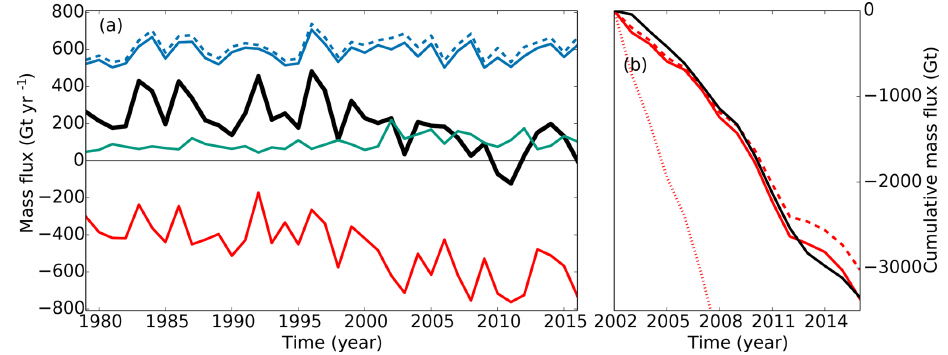
Figure 11. Surface mass balance as simulated by BEST m . (a) Total surface mass balance (black) and its components: accumulation (blue), total precipitation (blue dashed), melting (red), and refreezing (green). (b) Cumulative annual mass balance for GRACE (black), BEST m (red), BEST T (red dashed), and BEST A (red dotted).